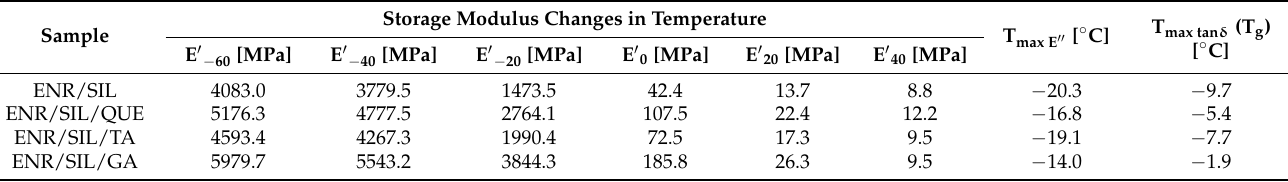
Table 3. Additional results showing the changes of properties in temperature for ENR/silica compos- ites containing selected natural phenolic compounds and the temperature values corresponding to the maxima detected for loss modulus and damping